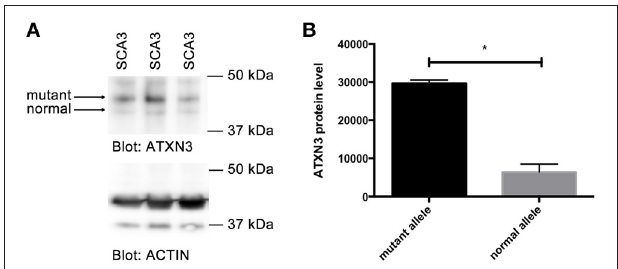
FIGURE 5 | Increased translation of mutant ATXN3 in SCA3 fibroblasts. (A) Western blot analysis of extracts from fibroblasts derived from a SCA3 patient carrying 74/22 CAG repeats in the ATXN3 gene is shown. Two ATXN3 bands were detected, one smaller translated from the normal, one bigger translated from the mutant allele. Actin was analyzed as control. (B) Quantifications of bands (protein expressed from the normal compared with protein expressed from the mutant allele) from (A) are shown. Mean values ± SEM are shown, n = 3, p < 0.0001. *Indicates statistically significant differences ( p <